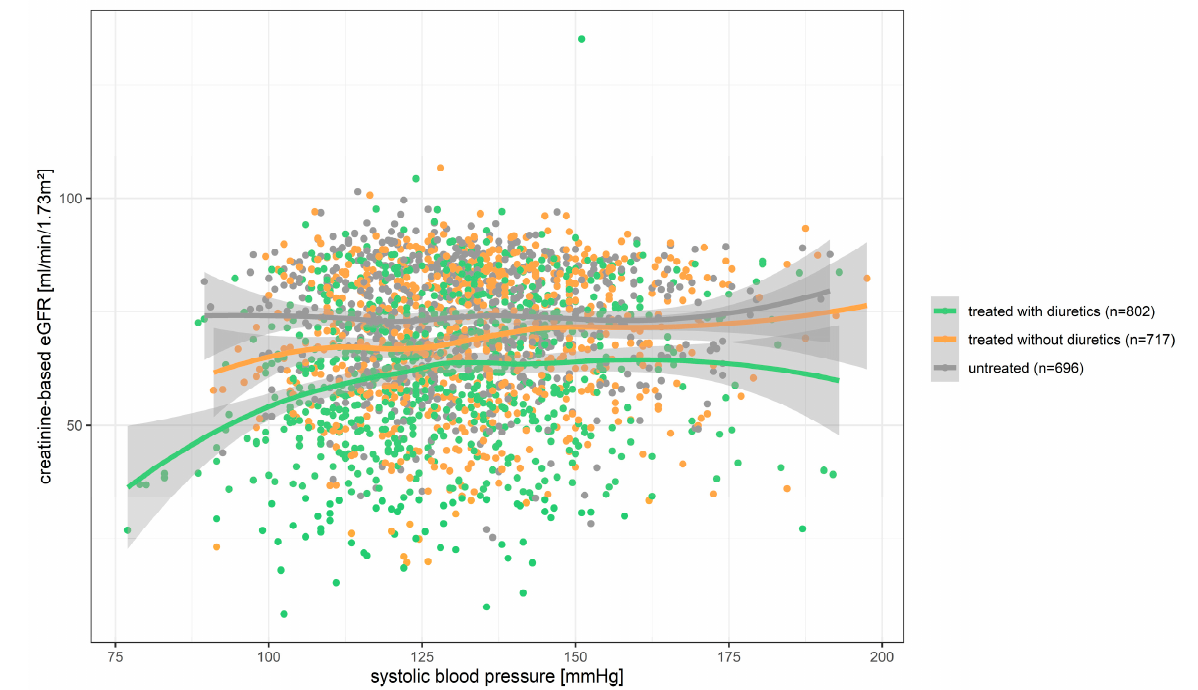
Figure 3. Creatinine-based eGFR versus systolic blood pressure stratified by blood-pressure-lowering medication and diuretics intake. Shown are values for each of the 2215 AugUR participants. A stratification was made between individuals without antihypertensive medication (grey), those with antihypertensive medication but without diuretic drugs (orange), and those taking diuretics (green). Loess best-fit curves with 95% confidence intervals were modeled for each group.